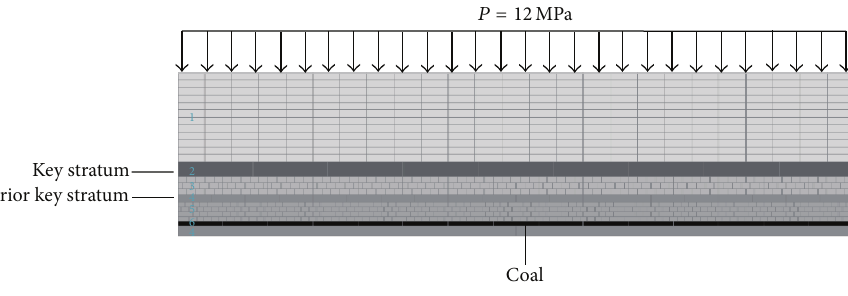
Figure 3: Numerical model.